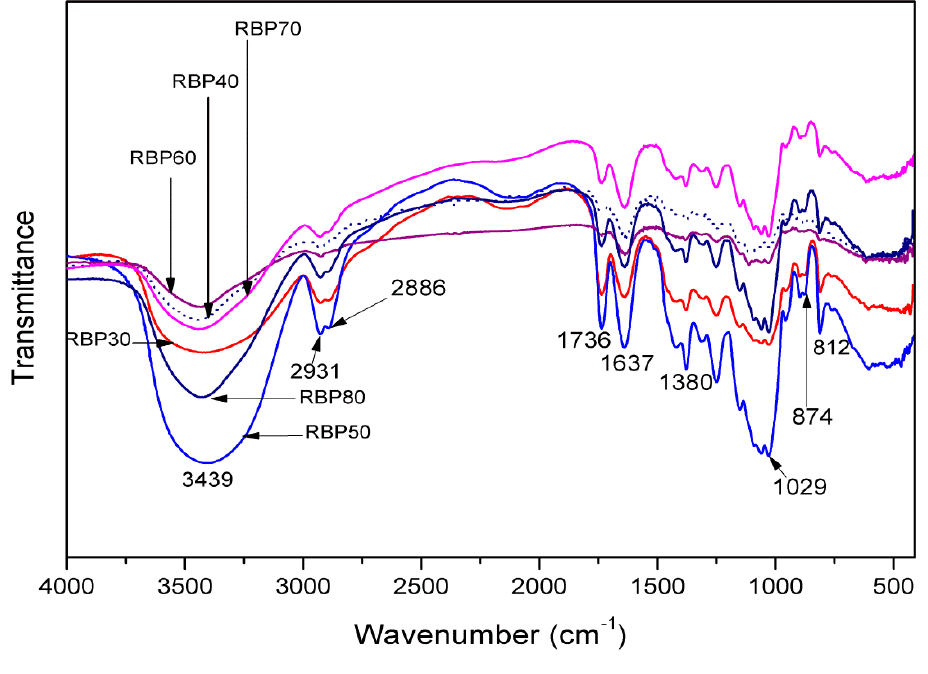
Figure 6. FTIR spectra of RBPs.